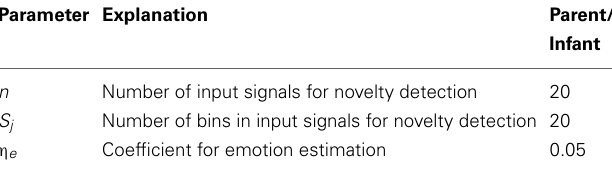
Table 4 | Other system parameters.